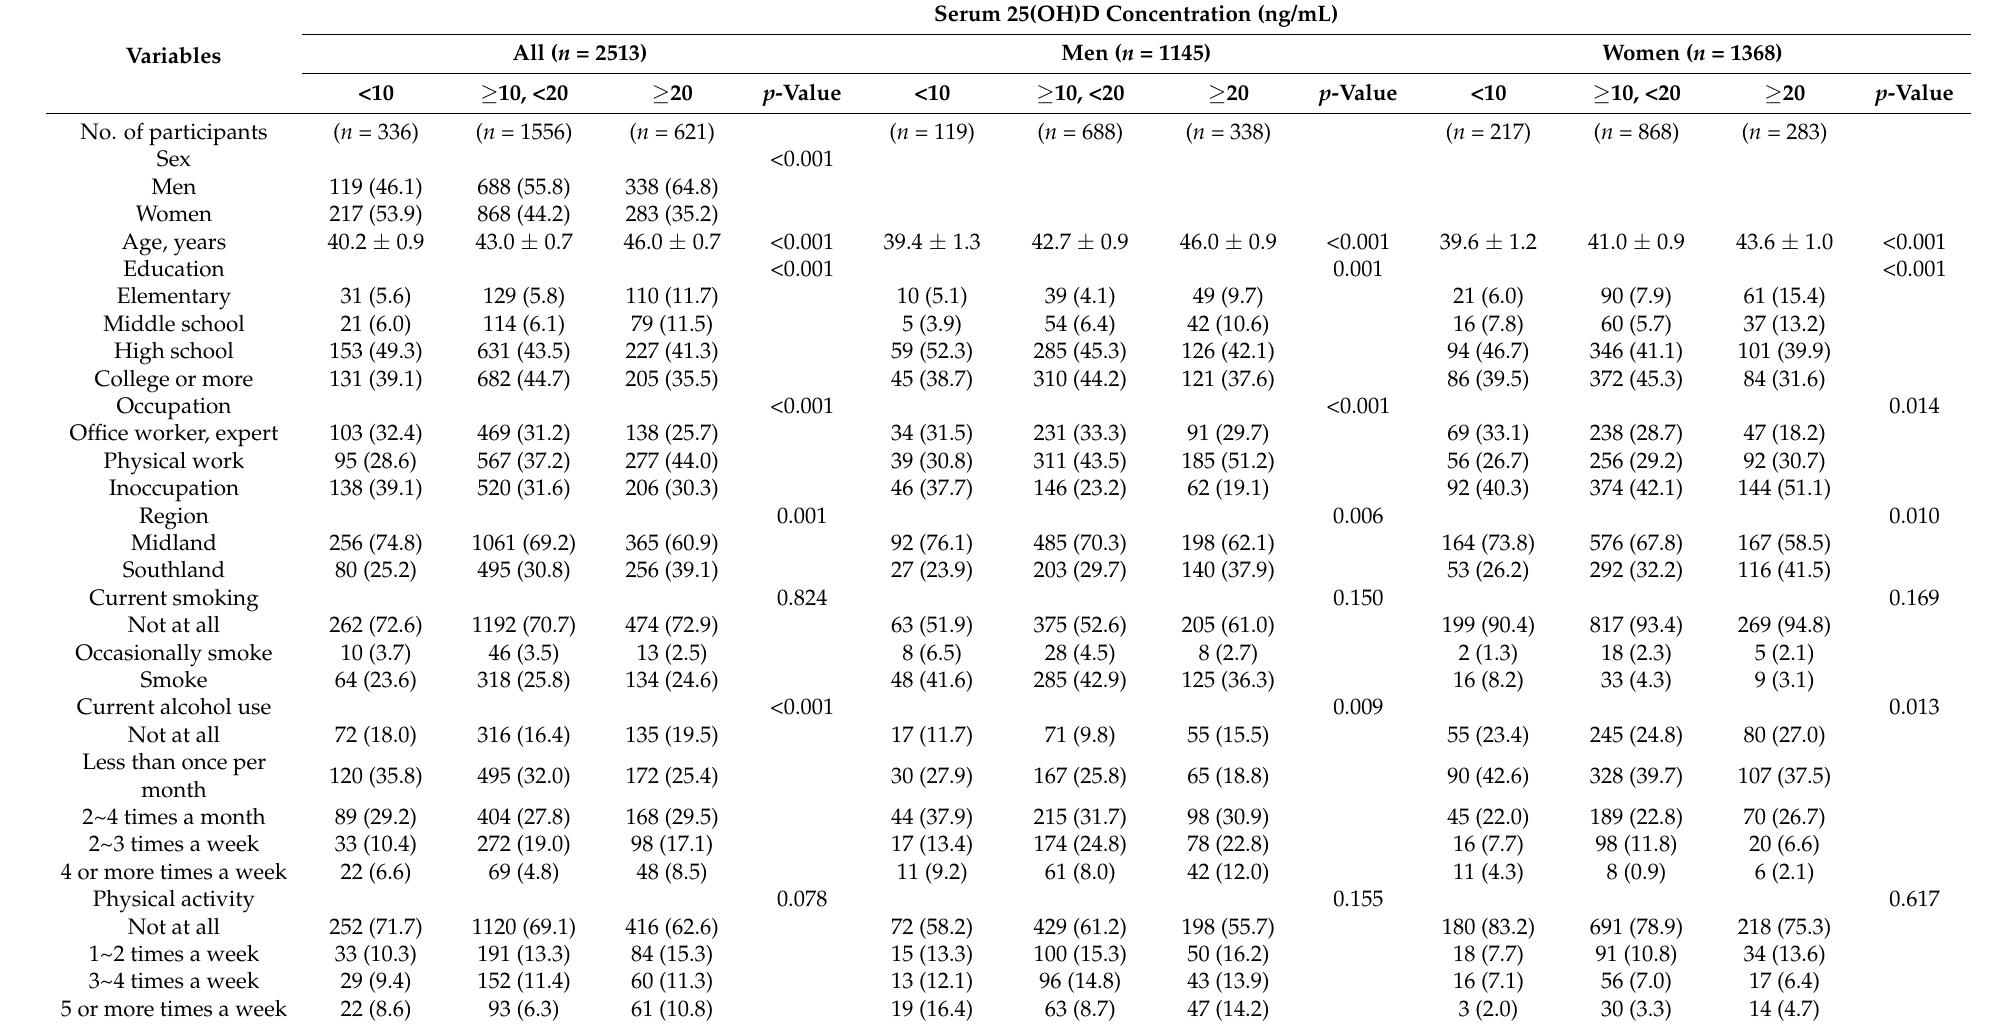
Table 1. General characteristics of the participants by categories of serum 25-hydroxyvitamin D (25(OH)D) concentration and